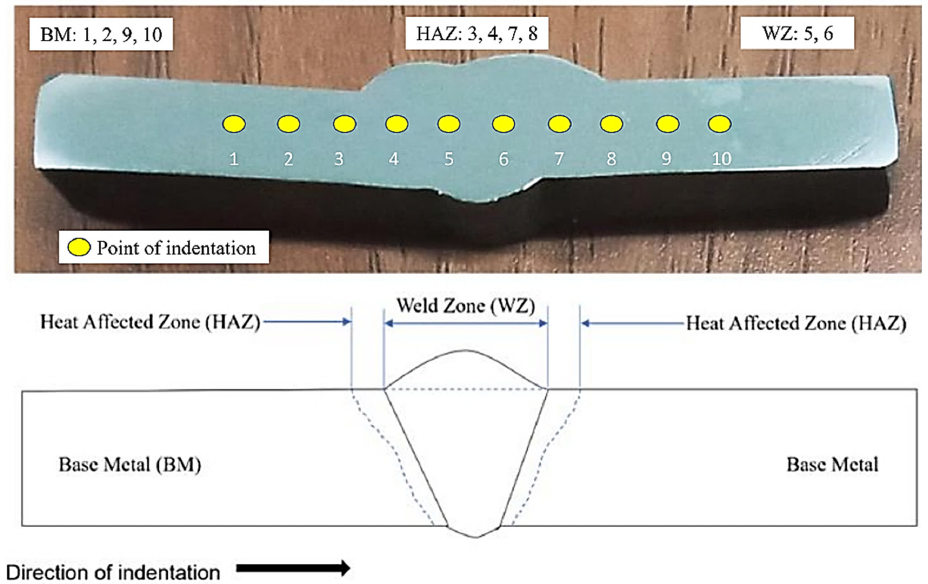
Figure 5. The direction and location of indentation for the micro-hardness